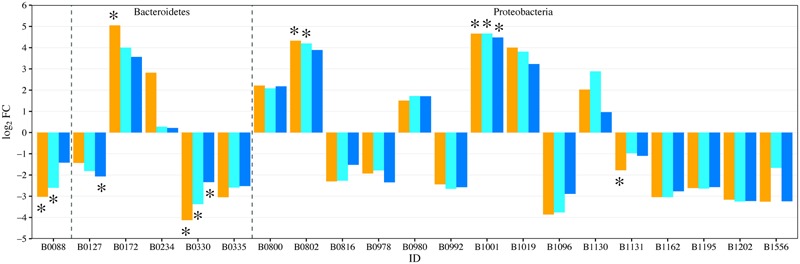
Fold change (log2FC) in bacterial phylotype abundance between U and each of the fertilized treatments (orange = P-only, light blue = NP16, dark blue = NP75). Only genera with fold change with p-value ≤ 0.05 are represented in the figure. ∗Represents change with false discovery rate (FDR) ≤ 0.05. B0088: Actinobacteria; Actinobacteria; PeM15 B0127: Bacteroidetes; VC2.1 Bac22 B0172: Bacteroidetes; Cytophagia; Algoriphagus B0234: Bacteroidetes; Flavobacteriia; Owenweeksia B0330: Bacteroidetes; Sphingobacteriia; Lewinella B0335: Bacteroidetes; Sphingobacteriia; uncultured Saprospiraceae B0800: Proteobacteria; Alphaproteobacteria; Brevundimonas B0802: Proteobacteria; Alphaproteobacteria; Phenylobacterium B0816: Proteobacteria; Alphaproteobacteria; DB1-14 B0978: Proteobacteria; Alphaproteobacteria; Roseovarius B0980: Proteobacteria; Alphaproteobacteria; Rubribacterium B0992: Proteobacteria; Alphaproteobacteria; Tabrizicola B1001: Proteobacteria; Alphaproteobacteria; uncultured Rhodobacteraceae B1019: Proteobacteria; Alphaproteobacteria; Roseococcus B1096: Proteobacteria; Alphaproteobacteria; Candidatus Captivus B1130: Proteobacteria; Alphaproteobacteria; Erythrobacter B1131: Proteobacteria; Alphaproteobacteria; Porphyrobacter B1162: Proteobacteria; Betaproteobacteria; GKS98 freshwater bacteria B1195: Proteobacteria; Betaproteobacteria; Polaromonas B1202: Proteobacteria; Betaproteobacteria; Variovorax B1556: Proteobacteria; Gammaproteobacteria; Vibrio